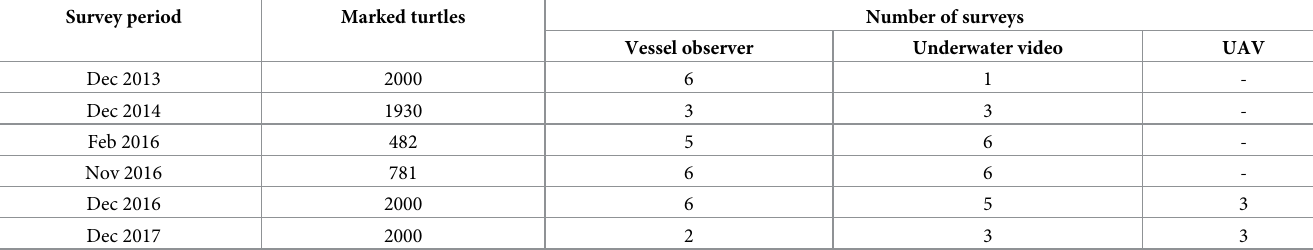
Table 1. Summary of survey periods, number of turtles marked and survey methods